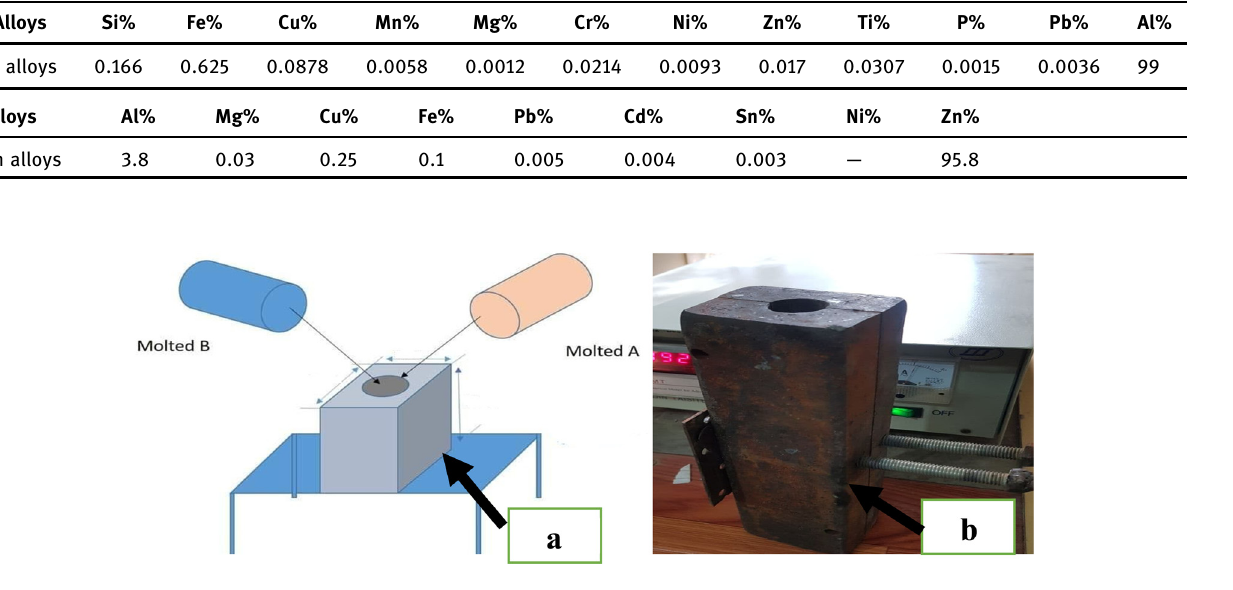
Figure 3: ( a ) The sketch of mold; ( b ) mold for sample casting.